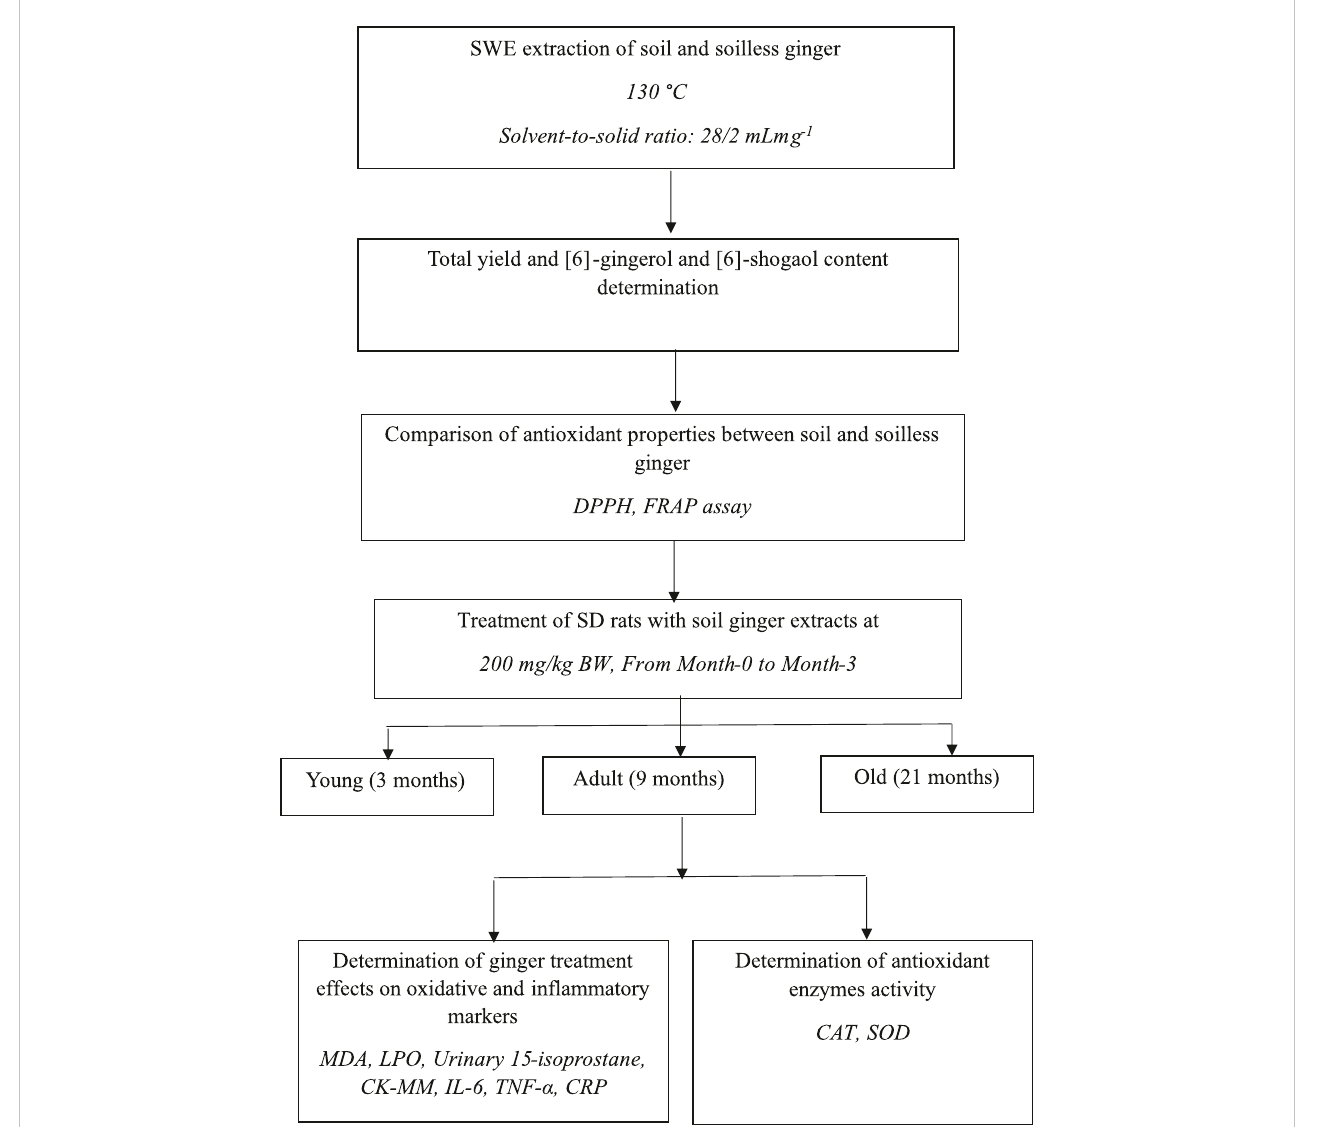
FIGURE 1 Diagram showing the experimental process and the study ’ s